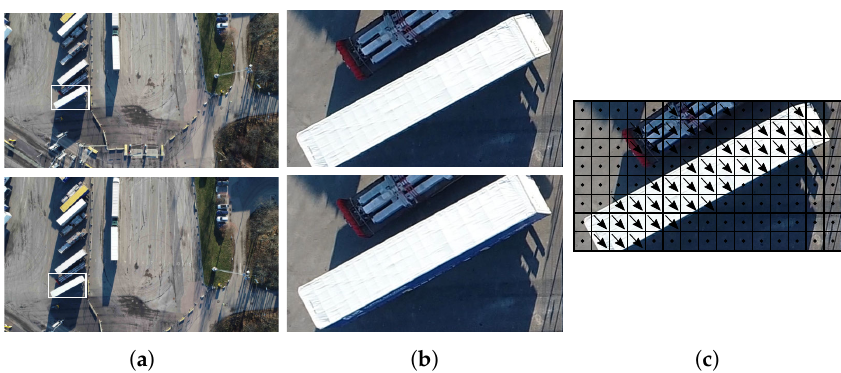
Figure 4. Parallax displacement calculation: ( a ) a pair of aerial images; ( b ) region of interest in both images after alignment based on the reference surface; ( c ) vector of parallax displacement for each pixel where its magnitude is considered D ( t )